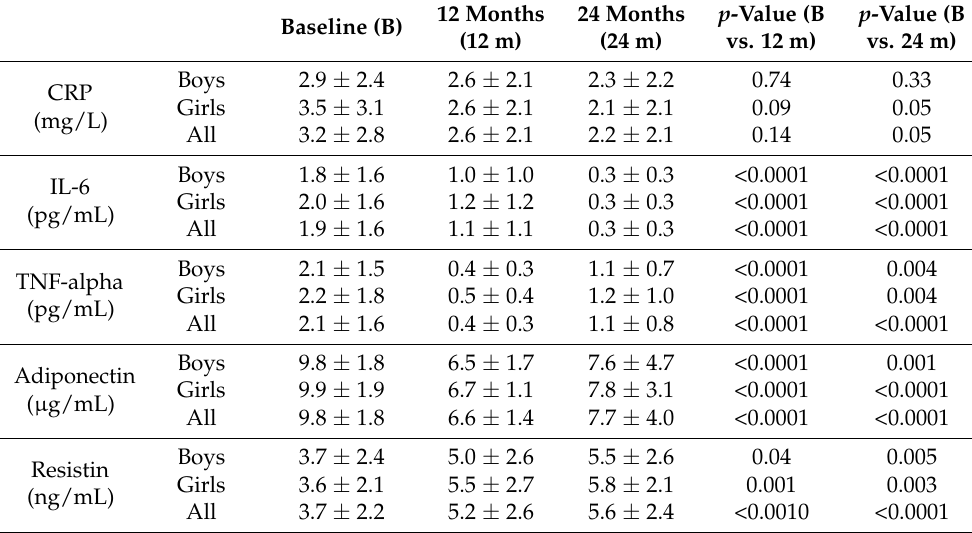
Table 3. Analytical parameters at baseline and after 12 and 24 months (m) of intervention in the total study population and by